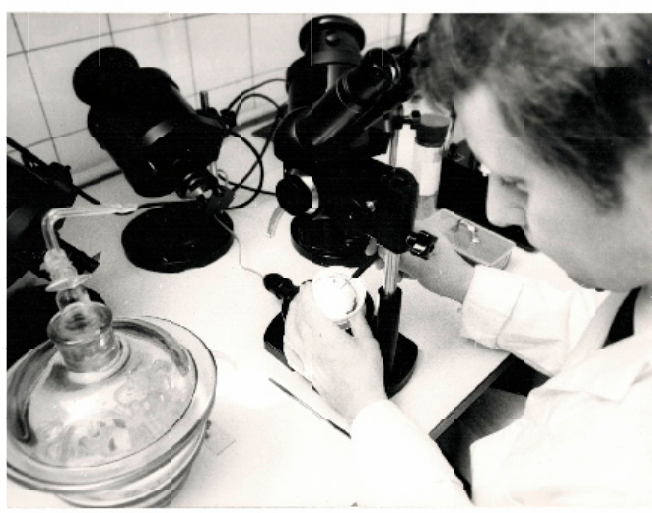
Figure 20. Inspection of the first synthetic diamonds by Vollstaedt.